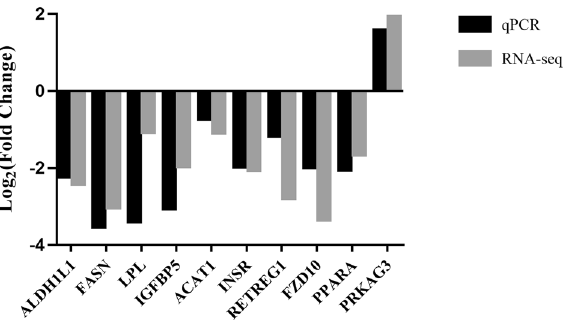
Figure 6. qPCR verification of genes in RNA-seq. The fold changes of the 10 genes showed that RT-qPCR results were consistent with the RNA-seq data. The fold change of qPCR was calculated as the ratio of expression between groups (HBF/LBF,